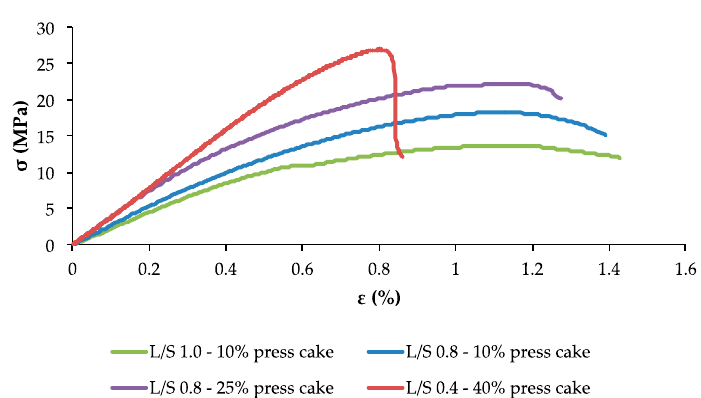
Figure 4. Flexural stress-strain curves determined through three-point bending tests of fiberboards produced with extrusion refined straw material using different liquid/solid (L/S) ratios and with different amounts of press cake.